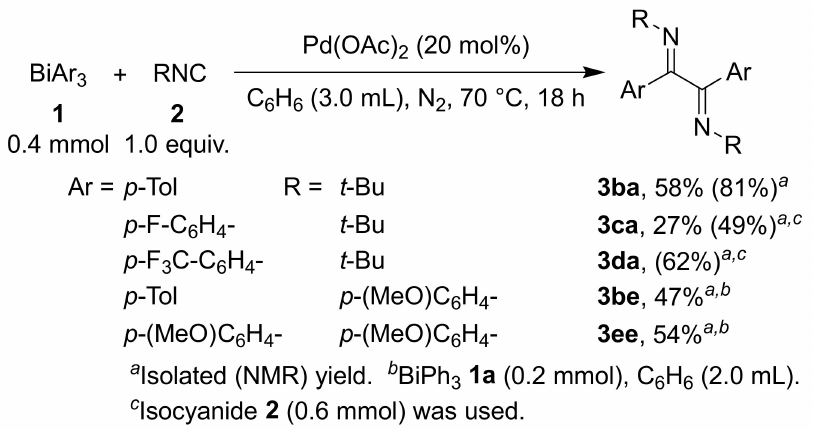
Scheme 4. Substrate scope of the Pd-catalyzed diarylation of isocyanides 2 with BiAr 3 1